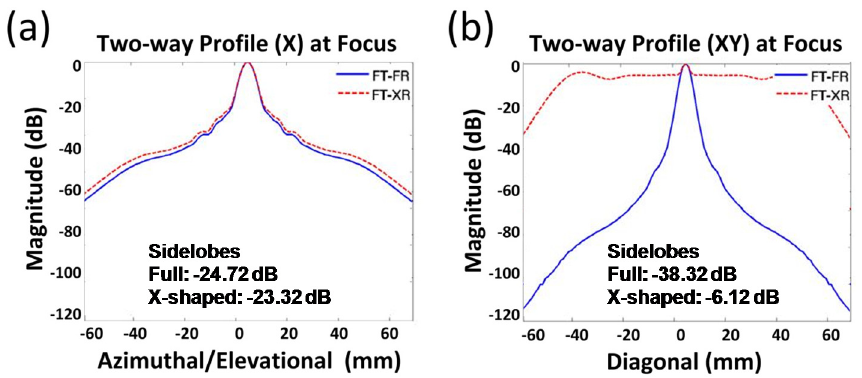
Figure 4. Two-way point spread functions (PSFs) of unfocused FT-FR and FT-XR in ( a ) azimuthal and Figure 4. Two ‐ way point spread functions (PSFs) of unfocused FT ‐ FR and FT ‐ XR in ( a ) azimuthal and ( b ) diagonal ( b ) diagonal planes.